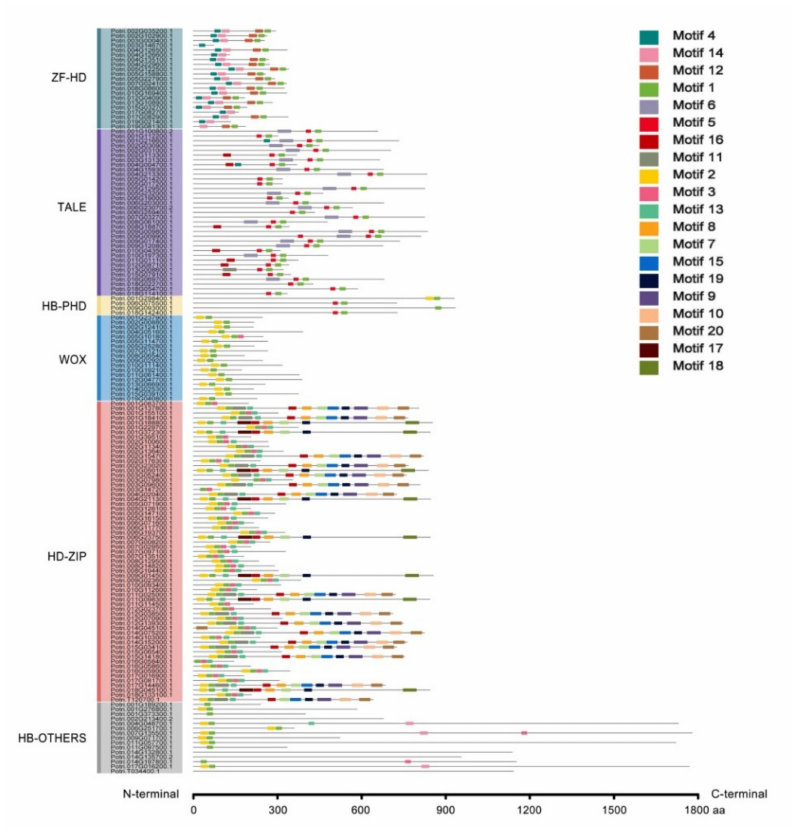
Figure 3. Conserved protein motifs of PtrHB members from each subfamily. The motif prediction was performed by the MEME online software. Different color boxes represent different types of